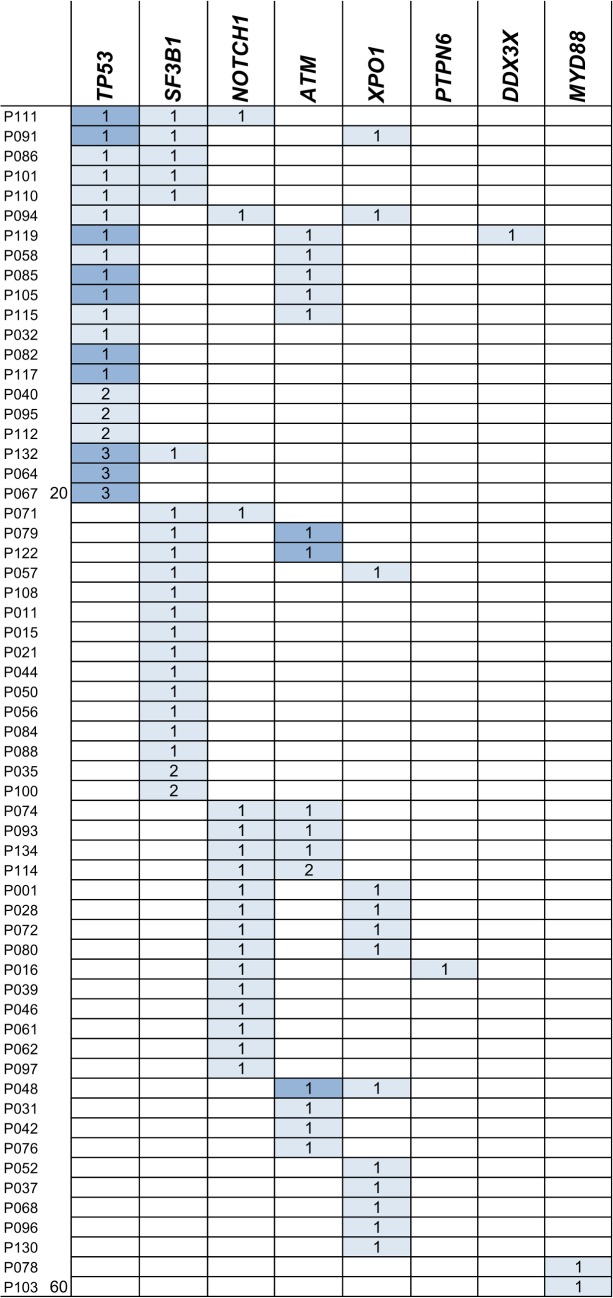
Genetic profile of 60 CLL samples carrying gene mutations determined by NGS.Each row represents the variants of one patient, each column summarizes the mutations occurring in one specific gene. Per each gene the number of mutations is given per patient. Dark blue samples indicate patients with aberration on chromosome 11 (del11q) for ATM mutated cases or on chromosome 17 (del17p) for TP53 mutated cases, determined by FISH.